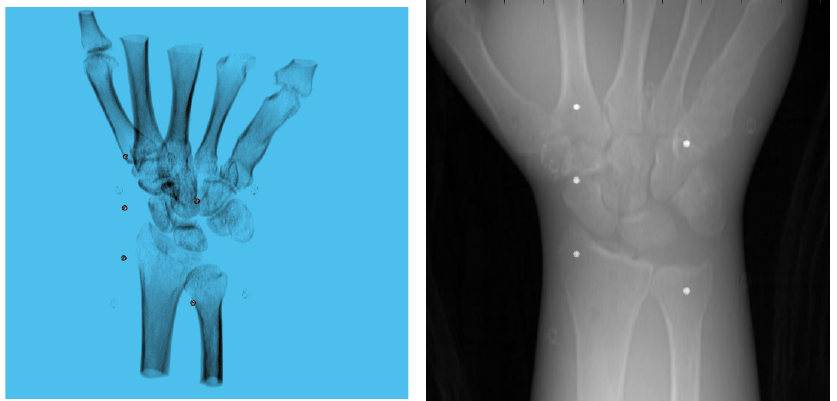
Figure 5. A 3D view of calibration board in Blender ( left ). A projection of the board ( right ).